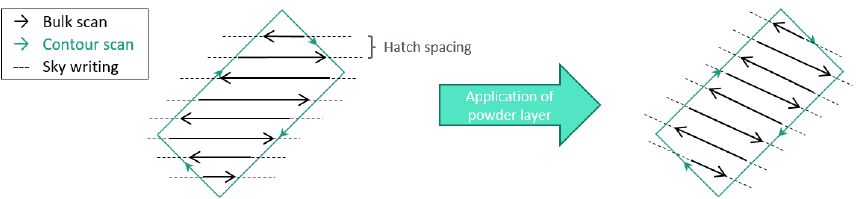
Figure 2. Exposure strategy for bulk and contour scan: bulk scan direction is rotated by 66 ◦ (schematic representation, not true to scale) after each powder layer application.